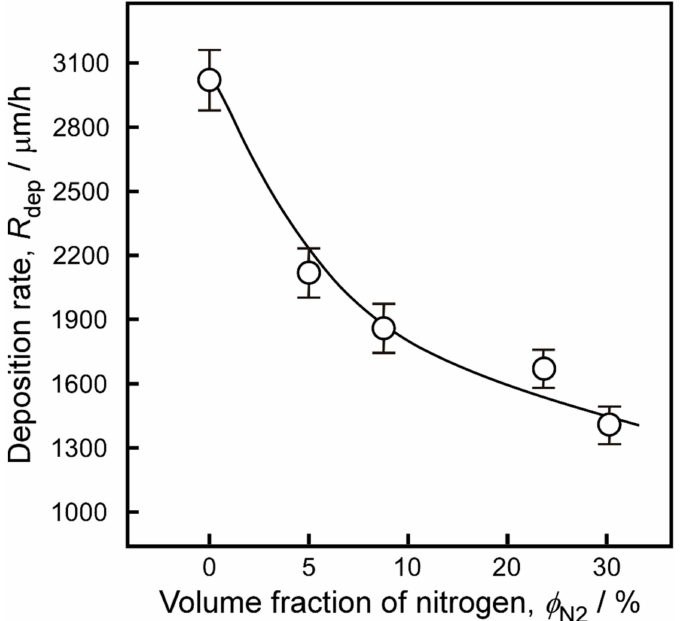
Figure 3. Surface and cross-sectional microstructure of N-doped 3C-SiC bulks obtained at T dep = 1623 K and P tot = 4 kPa, with φ N2 = 0% ( a , f ), 5% ( b , g ), 10% ( c , h ), 20% ( d , i ), and 30% ( e , j ).